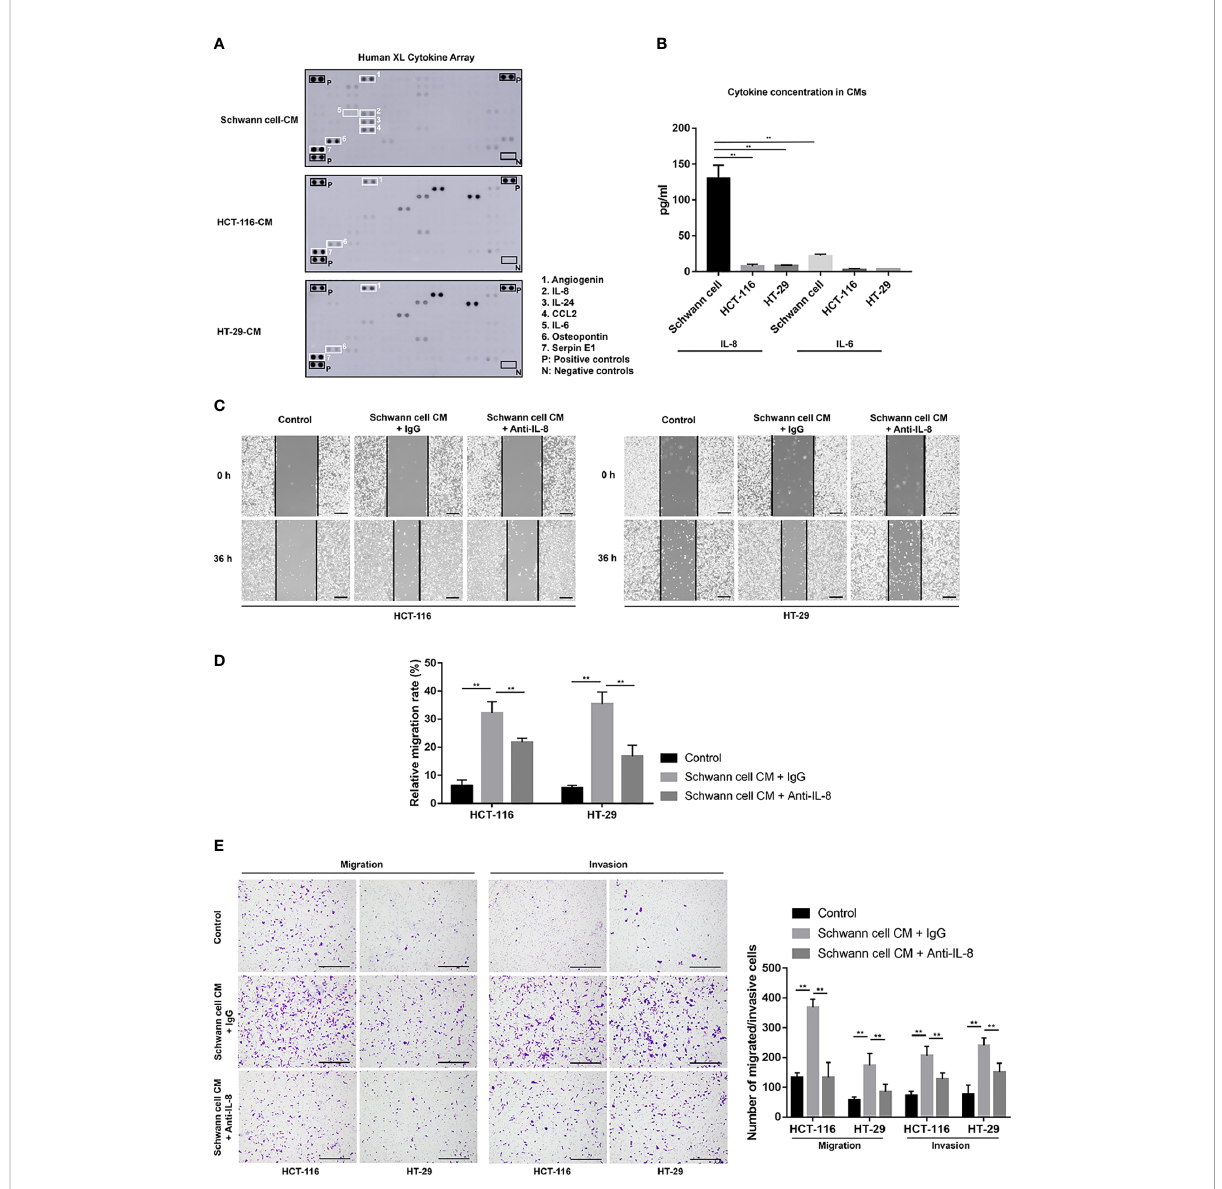
FIGURE 2 Anti-IL-8 treatment impairs the tumor-promoting effects of SCs on CRC cells. (A) A cytokine array ’ s original picture showed the paracrine factor pro fi les in SCs, HCT-116, and HT-29 cells. (B) ELISA results showed the secretion of IL-6 and IL-8 among SCs, HCT-116 and HT-29 cells. (C, D) Wound healing (scale bar, 400 µm) and (E) Transwell and Matrigel assays (scale bar, 400 µm) indicated that the neutralization of IL-8 in SC-CM suppressed the enhanced migration and invasion of HCT-116 and HT-29 cells. **P<0.01. CRC, colorectal cancer; CM, conditioned medium; IL-8, interleukin 8; SC, Schwann